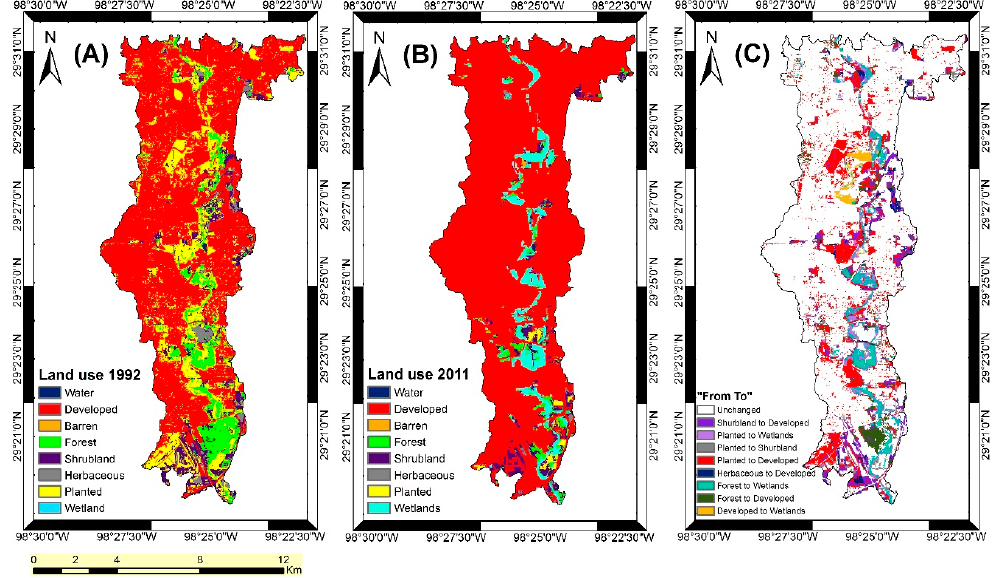
Figure 6. Land use types in the Walzem Creek watershed in: ( A ) 1992; ( B ) 2011; and ( C ) the transition between 1992 and 2011. Table 7. Transition matrix (in percentages) of land use change in Walzem Creek from 1992 to 2011.